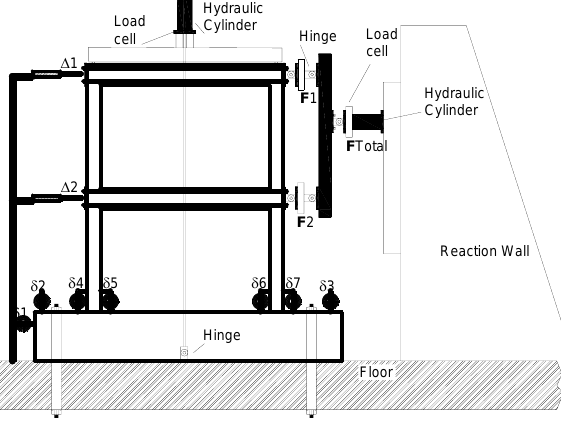
Figure 3 Test setup, loading system, and instrumentation Fig. 3. Test setup, loading system and